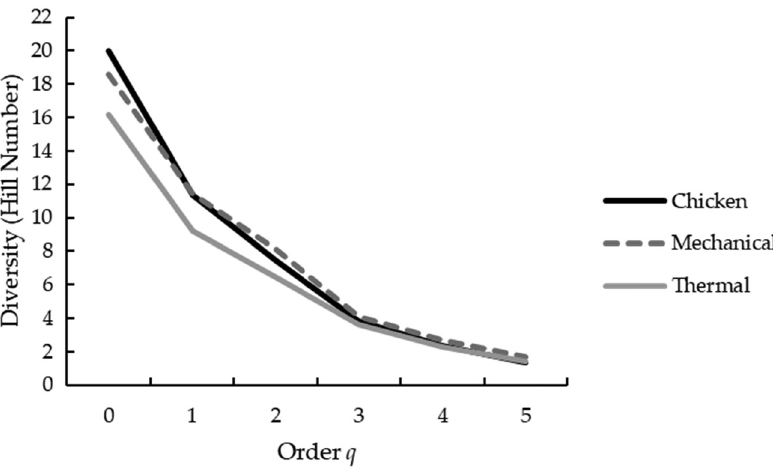
Figure 2: Diversity pro fi les ( Hill numbers ) of the di ff erent treatments after the intervention of treatments at the horticultural fi eld.